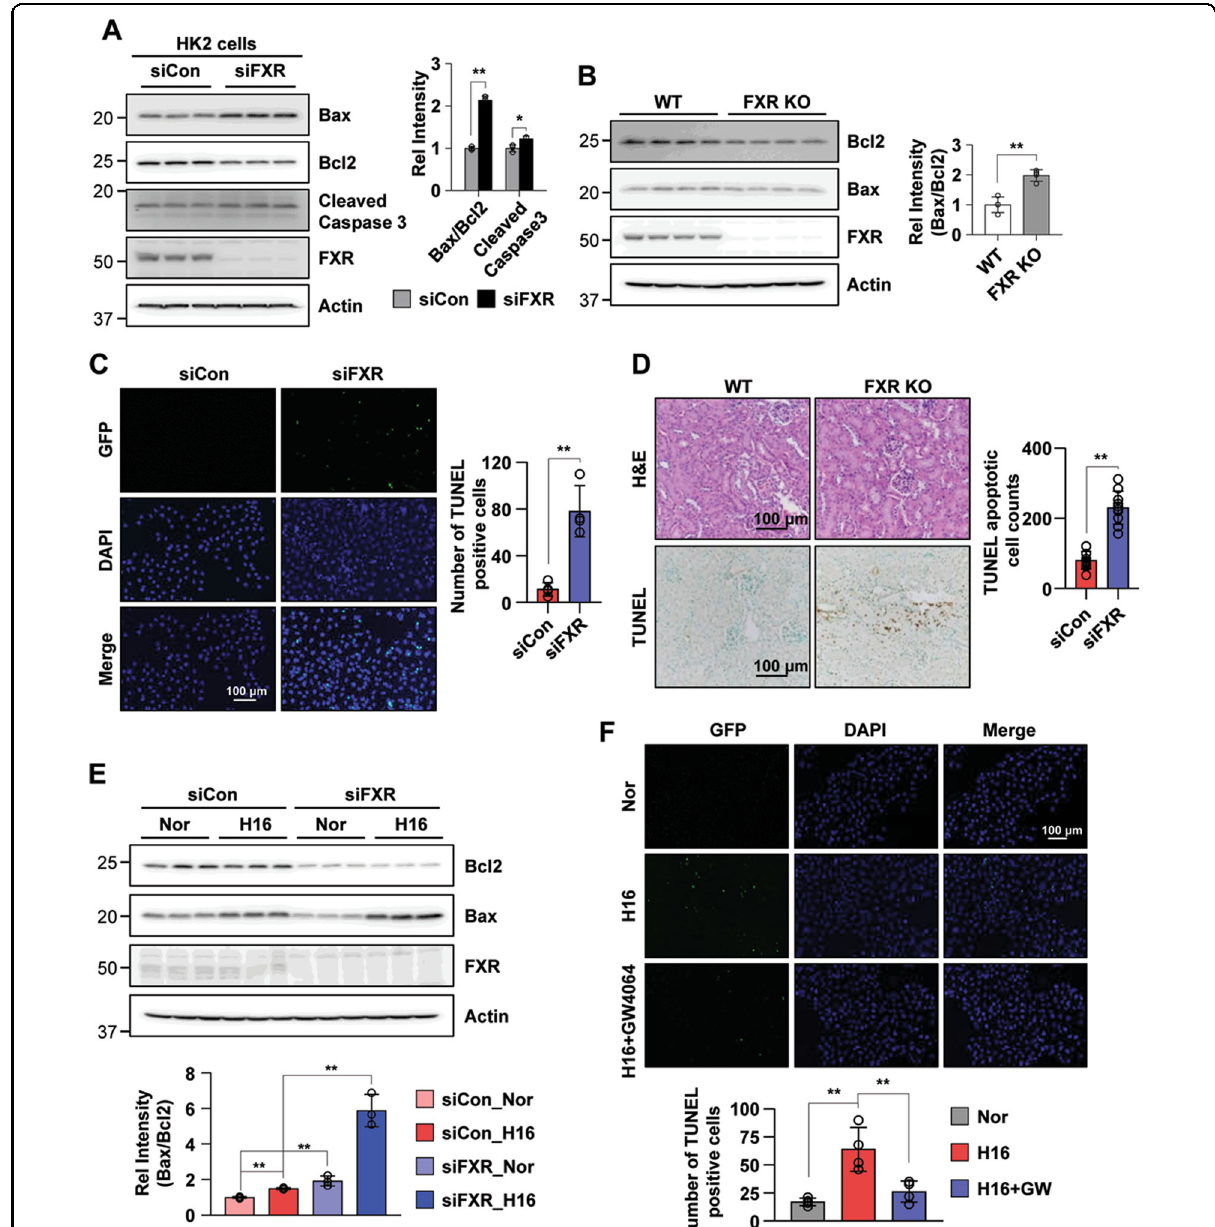
Fig. 5 FXR de fi ciency increases renal apoptosis. A – D Comparison of the protein expression levels of molecules related to apoptosis, as determined by immunoblotting ( A , B ) and TUNEL staining ( C , D ) in HK2 cells transfected with siRNA against FXR ( A , C ) and in the kidneys of WT and FXR KO mice ( B , D ). The relative protein levels are shown (right panel of A , B ) ( n = 3 – 4). The values for the siControl and WT were set to 1. Quantitative analysis of positive TUNEL staining (right panel of C , D ) ( n = 4 – 11). E HK2 cells were transfected with siRNA against FXR as indicated, and 48 h later, the cells were exposed to hypoxia for 16 h. The protein levels of the indicated genes were detected by immunoblotting, and the relative intensity of Bax/Bcl2 is shown. The value for the siControl normoxia was set to 1 ( n = 3). F Representative image of TUNEL staining. After treatment with GW4064 (500 nM) for 1 h, HK2 cells were exposed to hypoxia for another 16 h. Quantitative analysis of positive TUNEL staining is shown ( n = 4). All values are presented as the mean ± SD. Statistical signi fi cance was measured using one-way or two-way ANOVA with the Bonferroni post-test. * P < 0.05, ** P < 0.005. Nor normoxia, H16 hypoxia 16